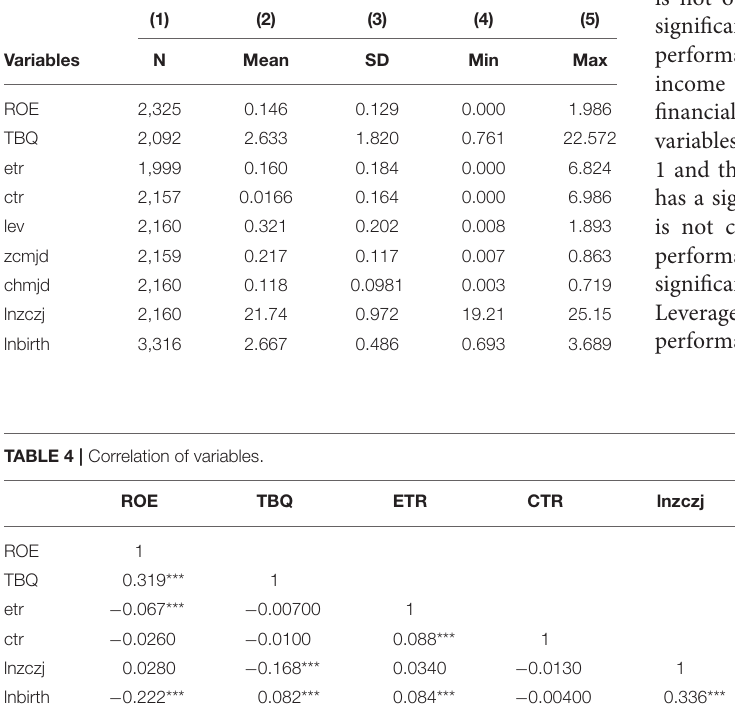
TABLE 3 | Description of variables.